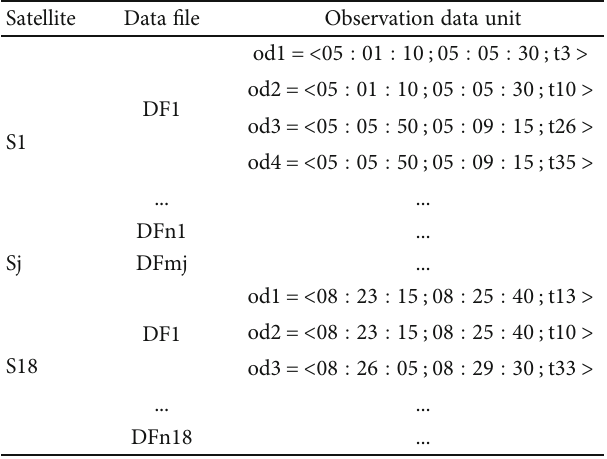
Table 1: Data fi les stored in satellites (partial). Satellite Data fi le